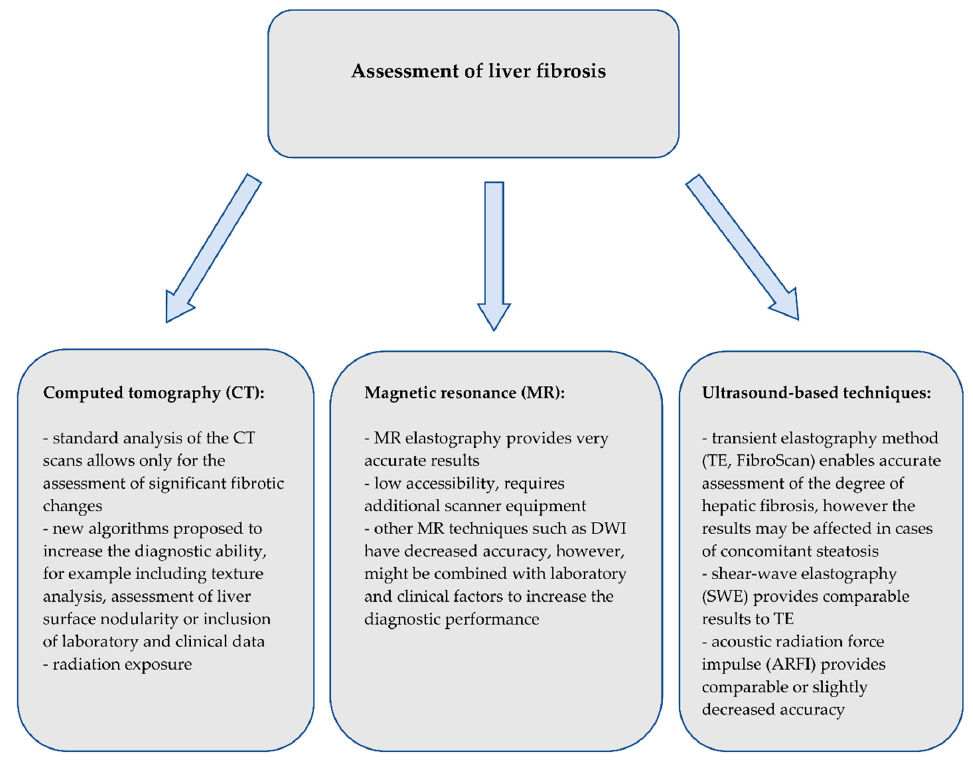
Figure 9. Summary of the imaging techniques for the assessment of liver fibrosis.